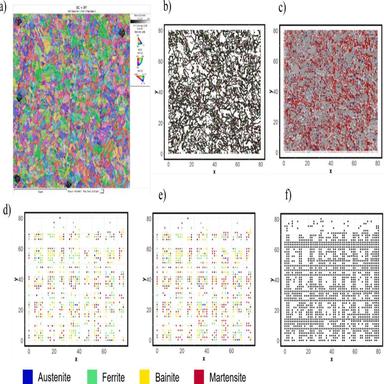
(a) IPF map from EBSD, (b) edge detection of the grain boundaries in IPF image within ROI, (c) clean EBSD phase map from grain boundaries, (d) initial nanoindentation scatter pattern with grain boundaries removed, (e) nanoindentation scatter pattern overlaid by EBSD and with grain boundaries removed and prediction of unvalidated values with machine learning (36.1% of initial raw data), (f) nanoindentation scatter corresponding to grain boundary location of indents. X and Y coordinates are presented in µm.